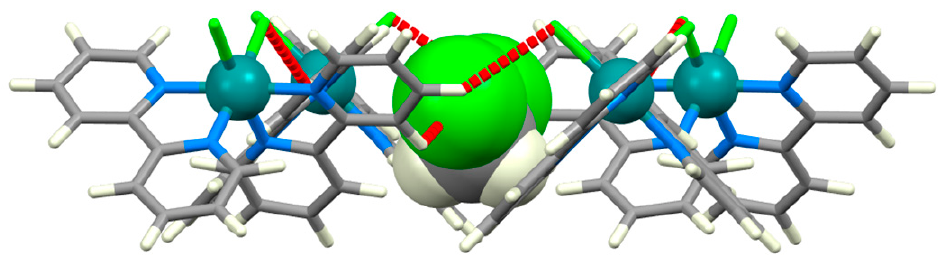
Figure 10. Encapsulation of a CH 2 Cl 2 molecule in the orthorhombic polymorph of cis- [Ru(bpy) 2 Cl 2 ] · 2CH 2 Cl 2 (CSD refcode KIJYEI [50]); bpy H3...Cl solvate and bpy H4...Cl complex contacts are shown in red.